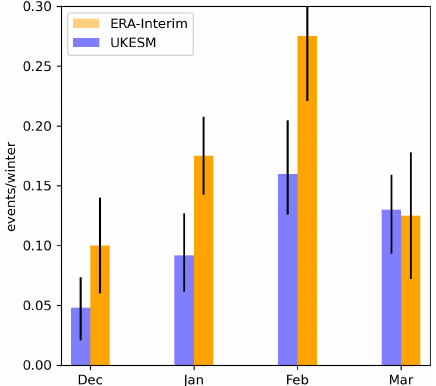
Figure 1. SSWs per NH winter season separated by month within the UKESM piControl and ERA-Interim datasets. Error bars are derived using a bootstrap resampling method in which random se- lections of 50 years are chosen from the SSW data and the SSW rate recorded to build a PDF of events per season. In total, 10000 such resamples are carried out, and the 97.5 and 2.5 percentile values are used as error